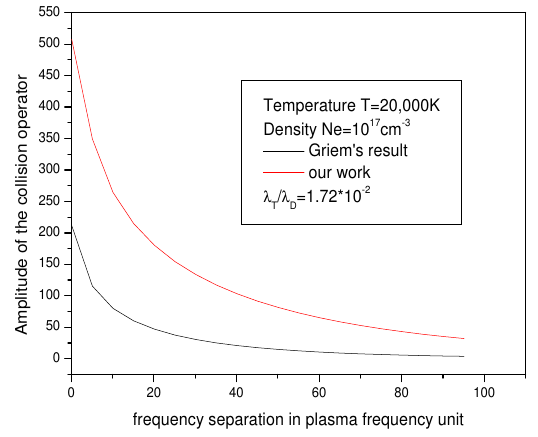
Figure 3. Amplitude of collision operator versus frequency separation in plasma frequency unit ¯ ω αα (cid:48) for Ne=10 17 cm − 3 and a temperature 20,000K. The amplitude is in π 2 A /768 unit, where A is defined in the text as Equation